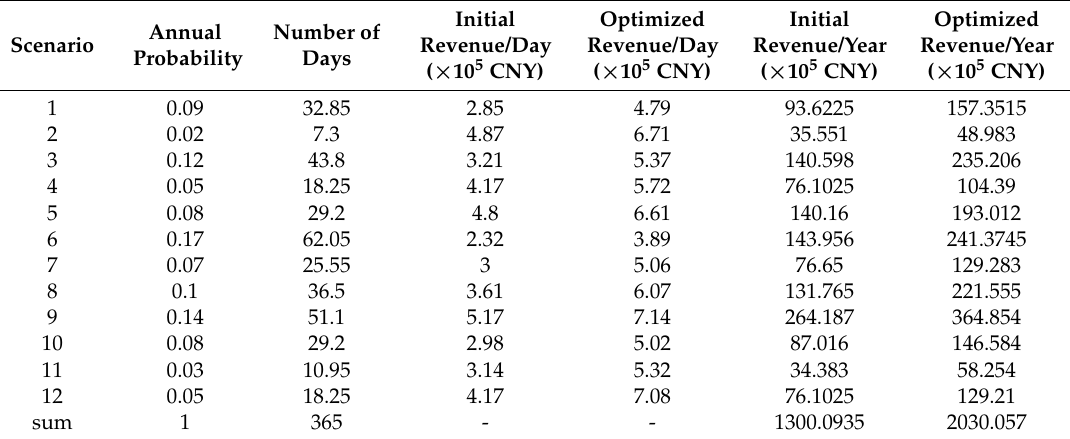
Table 8. The annual revenue of the